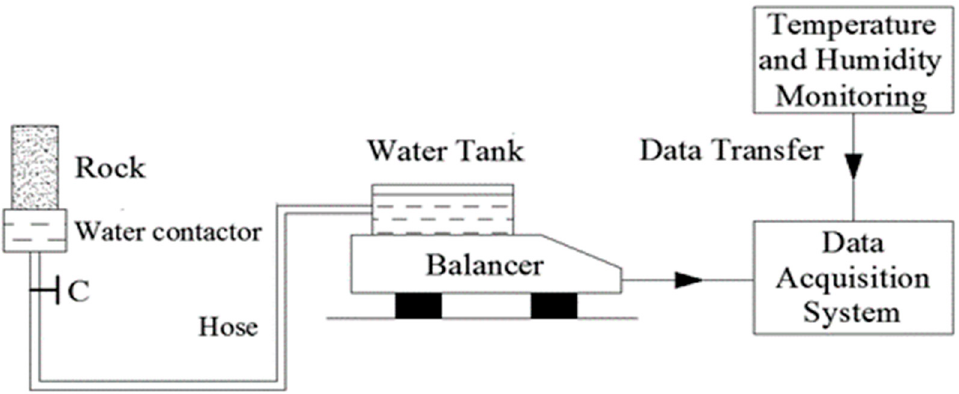
Figure 2. Sketch for real-time monitoring experimental system for imbibition test without water pressure.